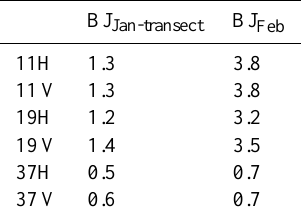
Figure 7. RMSE σ for bare frozen soil sites (snow excavation experiment, SEex) as a function of soil roughness ( σ ) for (left) JB Jan-transect and (right) JB Feb . The optimized σ for each site is given in parentheses.